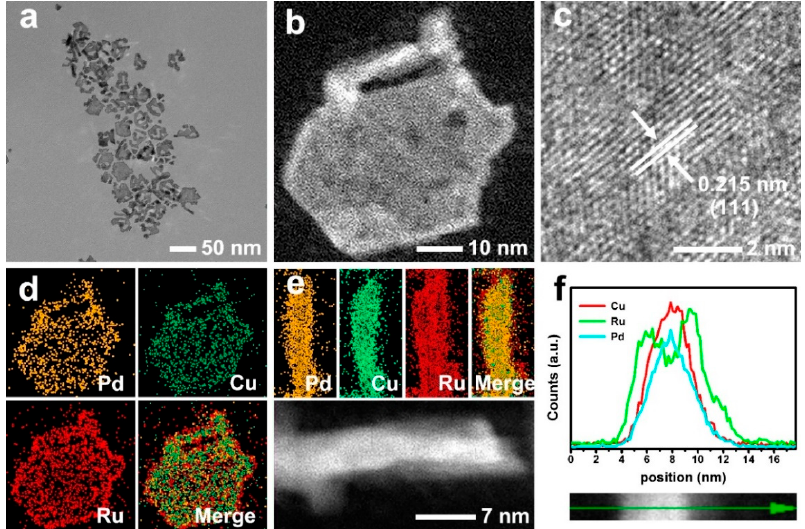
Figure 1. ( a ) TEM, ( b ) HAADF-STEM ( c ) HRTEM and ( d ) HAADF-STEM-EDX mapping images of a planar Pd 24 Cu 29 Ru 47 nanoplate. ( e ) HAADF-STEM-EDX images of a vertically upstanding Pd 24 Cu 29 Ru 47 nanoplate. Pd (orange), Ru (red), and Cu (green). ( f ) Line-scan profiles along the side of a Pd 24 Cu 29 Ru 47 nanoplate.